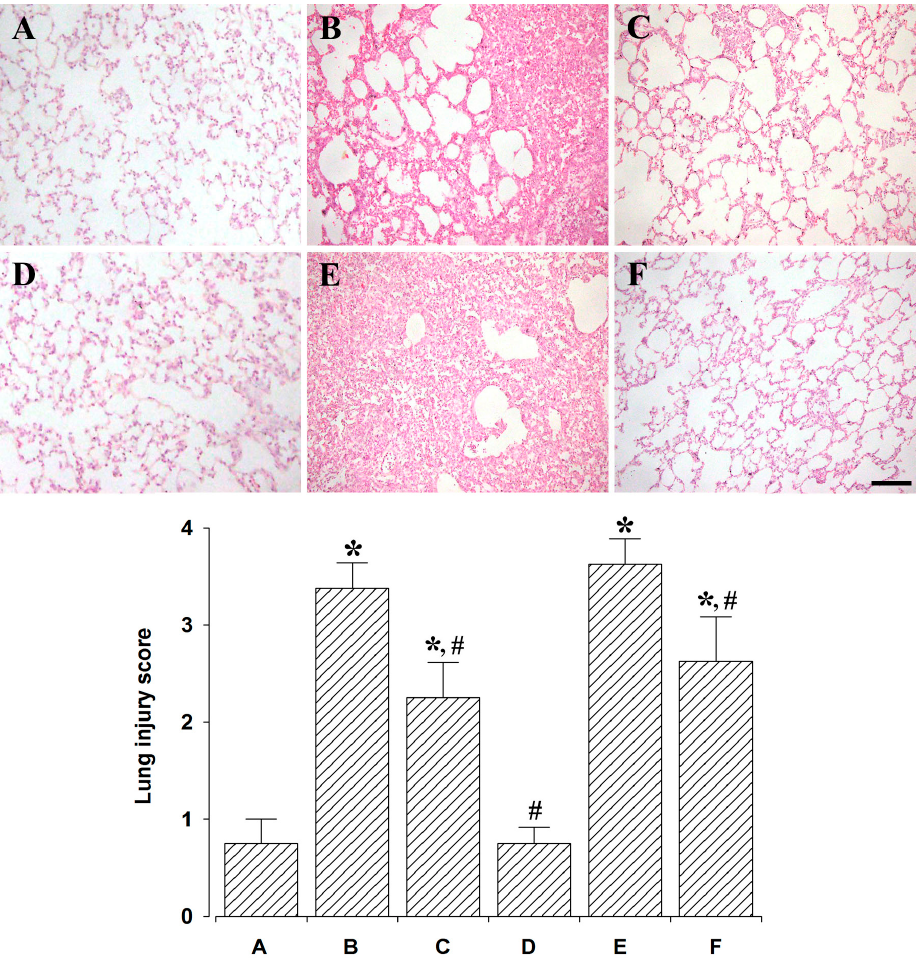
Figure 1. Effect of polydeoxyribonucleotide (PDRN) treatment on the lung injury score. Upper : Photomicrographs of lung injury. The scale bar represents 100 μ m. ( A ) Control and 24 h after sacrifice group; ( B ) Lung injury and 24 h after sacrifice group; ( C ) Lung injury with PDRN-treatment and 24 h after sacrifice group; ( D ) Control and 72 h after sacrifice group; ( E ) Lung injury and 72 h after sacrifice group; ( F ) Lung injury with PDRN-treatment and 72 h after sacrifice group. Lower : Lung injury score in each group. * represents p < 0.05 compared to the control and 24 h after sacrifice group. # represents p < 0.05 compared to the lung injury and 24 h after sacrifice group.